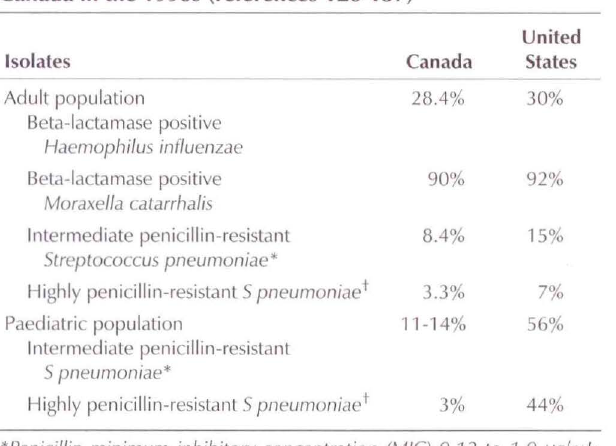
Incidence of bacterial resistance in the United States and Canada in the 1990s (references 126-13